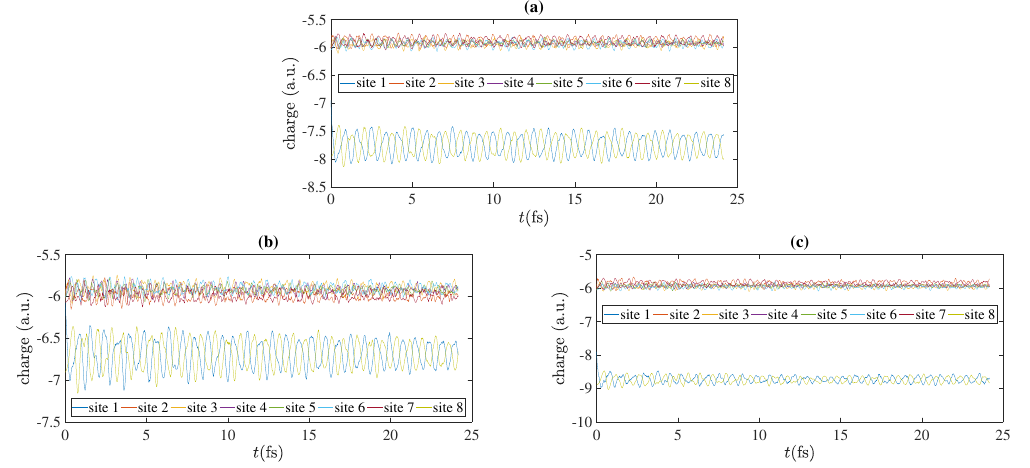
Figure 12. Charge oscillations obtained by RT-TDDFT, at the B3LYP/cc-pVTZ level of theory, N = 8, for cumulenic ( cu ) molecules with coplanar ( co ) methylene groups as well as polyynic ( po ) molecules starting with short ( sl ) or long ( ls ) bonds. ( a ) cu co , ( b ) po sl , ( c ) po ls